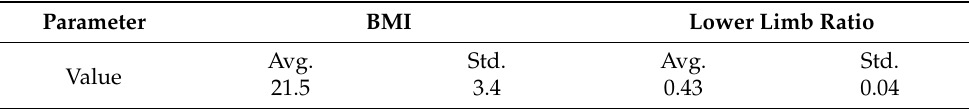
Table 3. Details of the participants.